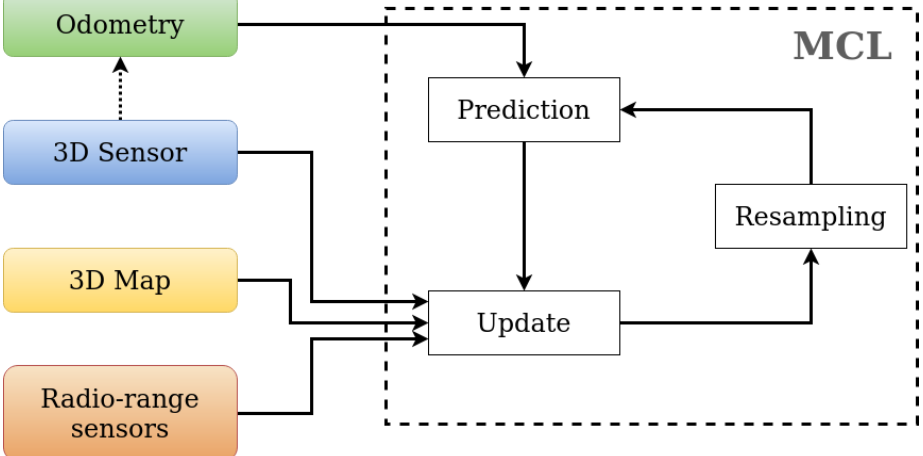
Figure 3. Complete scheme of the